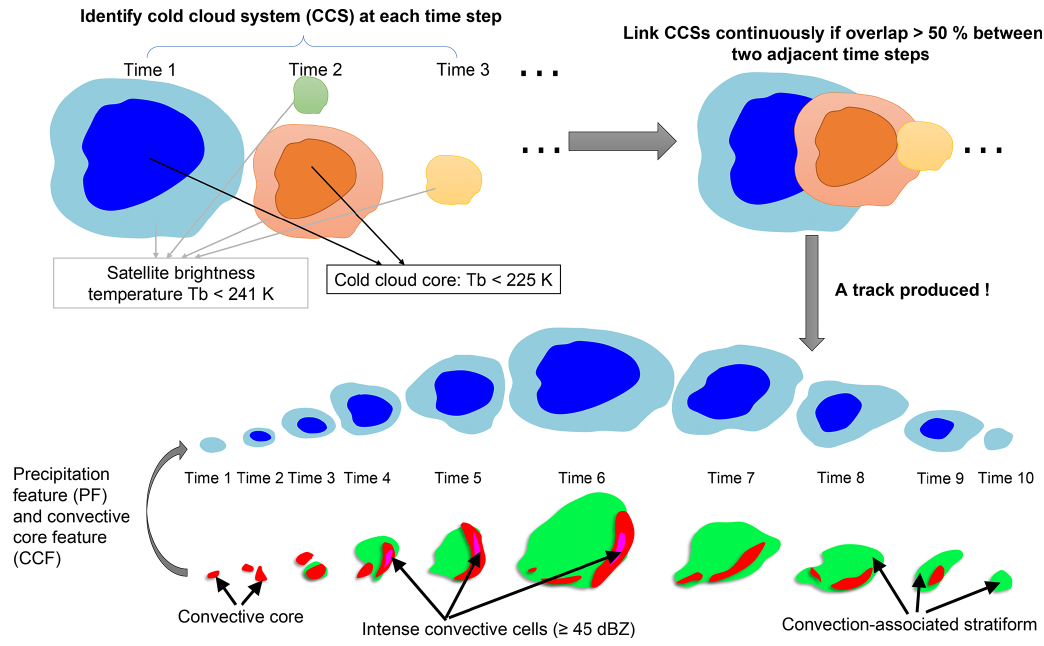
Figure 3. Schematic of the FLEXTRKR algorithm highlighting three key steps in the algorithm: (1) the identification of CCS (upper left), (2) linking of overlapping CCSs (upper right), and (3) the tracking of both PF and CCF (bottom).